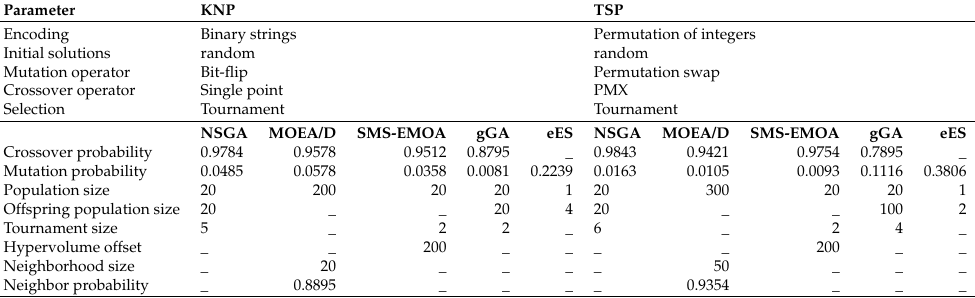
Table 4. Parameter settings for each problem-algorithm